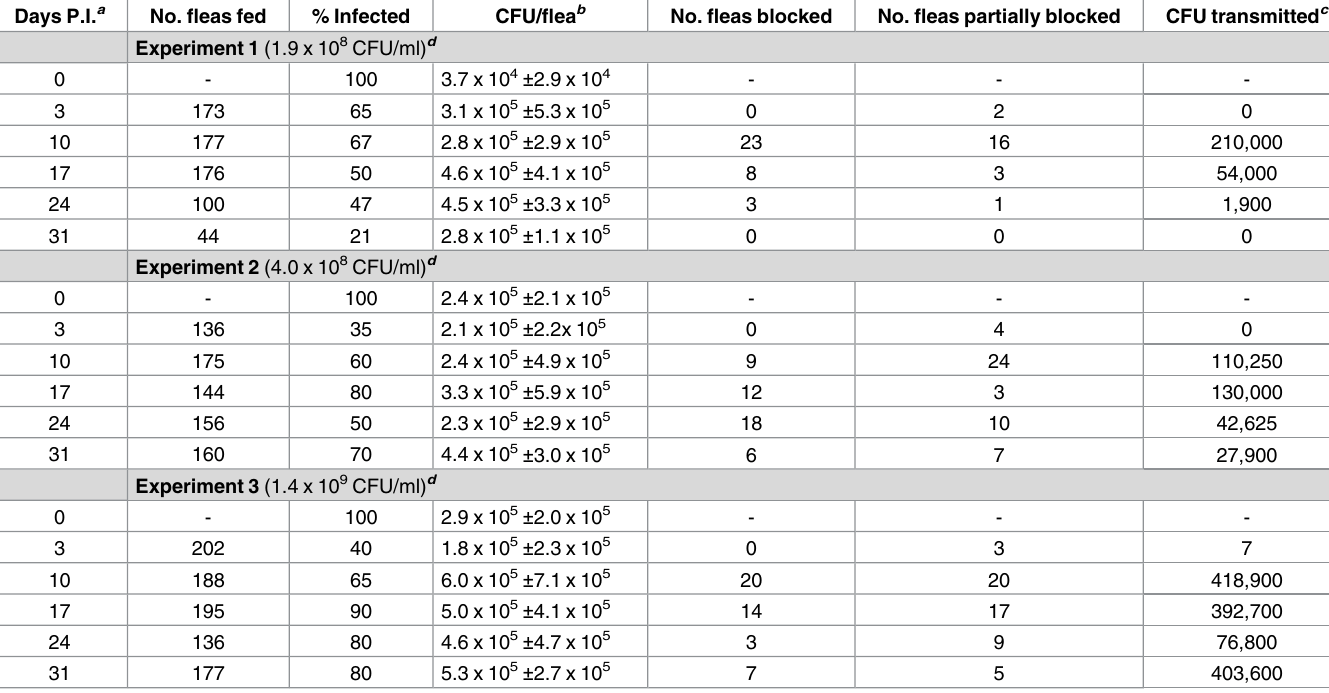
a Days after the infectious blood meal. Day 0 indicates the day of infection; data for this day are included to show the initial infectious dose (no transmission test was done). b Mean ± SD in infected fleas. c Data used for Fig 4A. d Conc. of Y . pestis in infectious blood meal on day